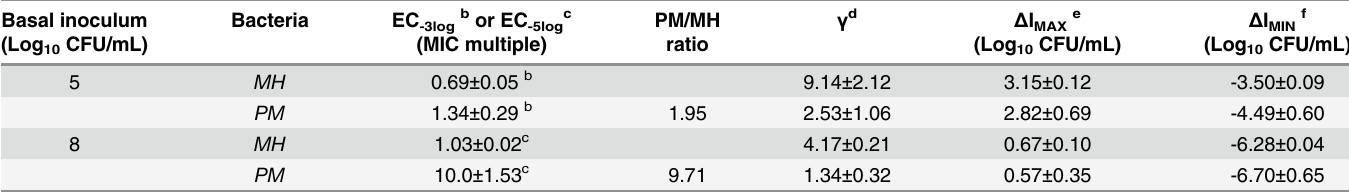
a Mean ± SE of parameters calculated with Eqs 2 and 3 (sigmoid E b Antibiotic concentration reducing by 3 log c Antibiotic concentration reducing by 5 log d Sigmoid coef fi cient of the curve. e Maximal growth compared to the basal inoculum. f Minimal growth (maximal killing) compared to the basal inoculum.